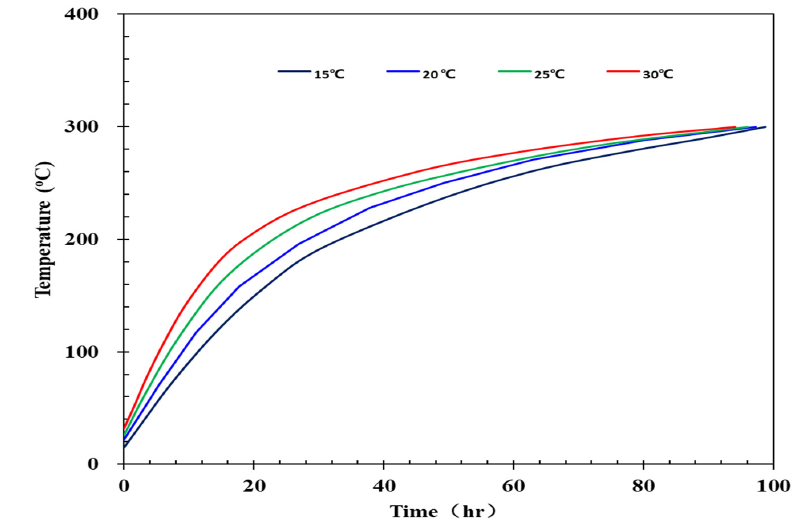
Figure 14. Wellbore heating characteristic curve.